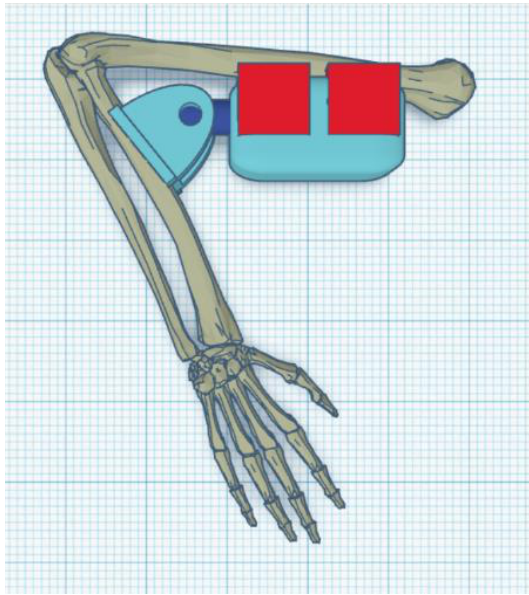
Figure 12. Upright exoskeleton with arm (0 ).